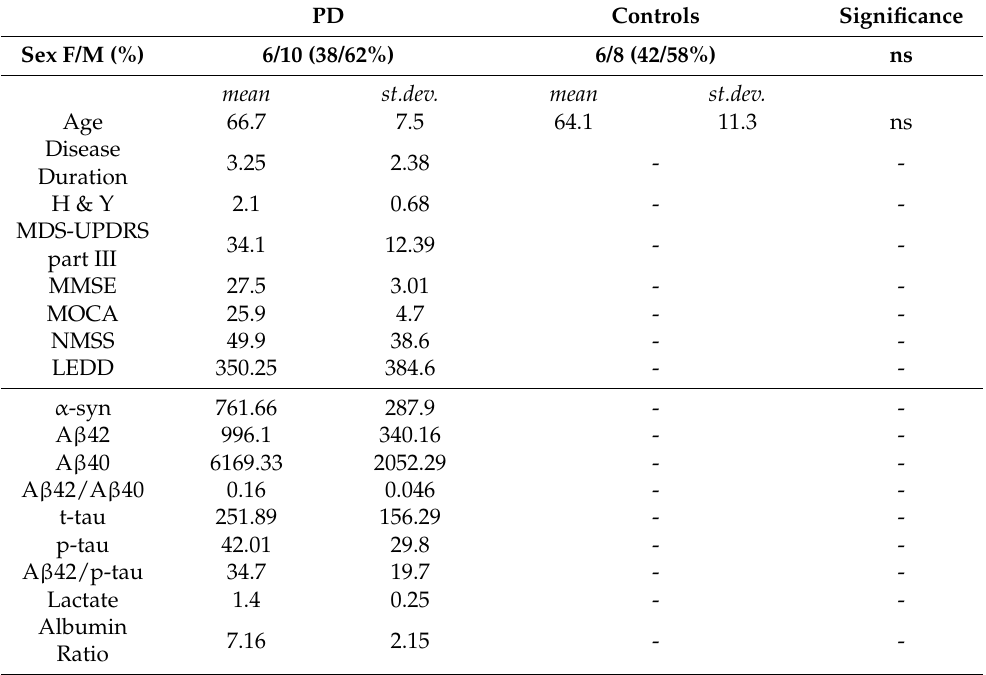
Table 1. Demographics, clinical parameters and CSF biomarkers of the study population. Age and disease duration are expressed in years; biomarkers in pg/mL. F = female; M = male; ns = not significant; other abbreviations are spelled out in the